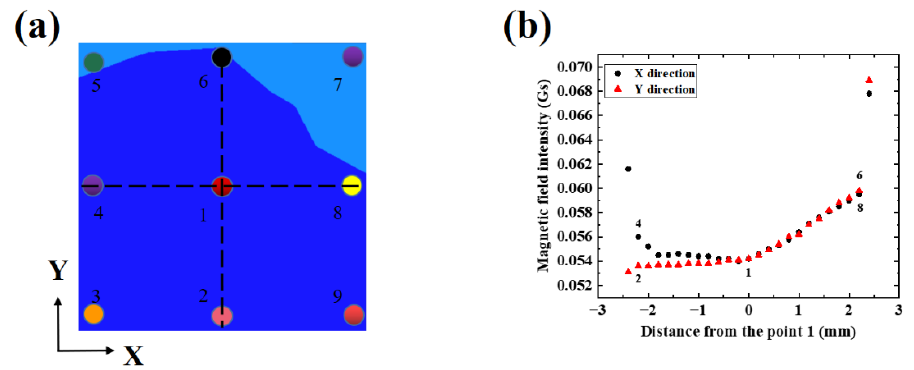
Figure 2. ( a ) Schematic diagram of the hollow area; ( b ) The simulated magnetic field strength in the range of [ − 2.4 mm, 2.4 mm] of the x -axis and y -axis, respectively.